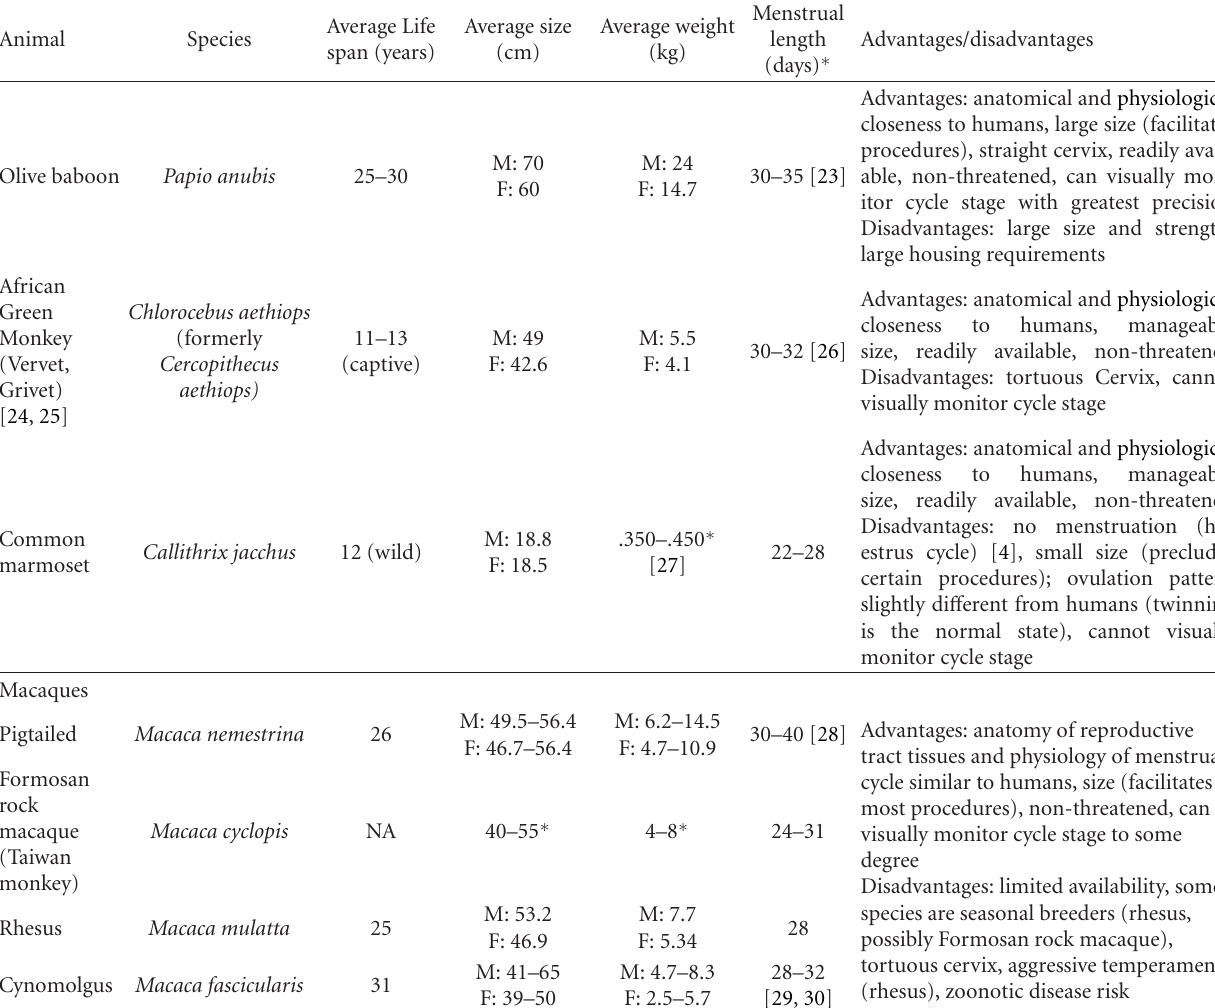
Table 1: List of NHP used in reproductive health